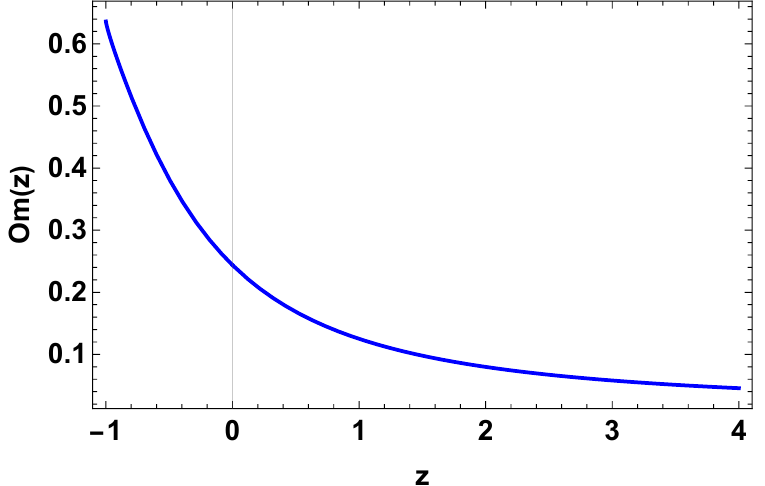
Figure 6. Profile of Om diagnostic parameter, with the agreement of obtained observational constraints.